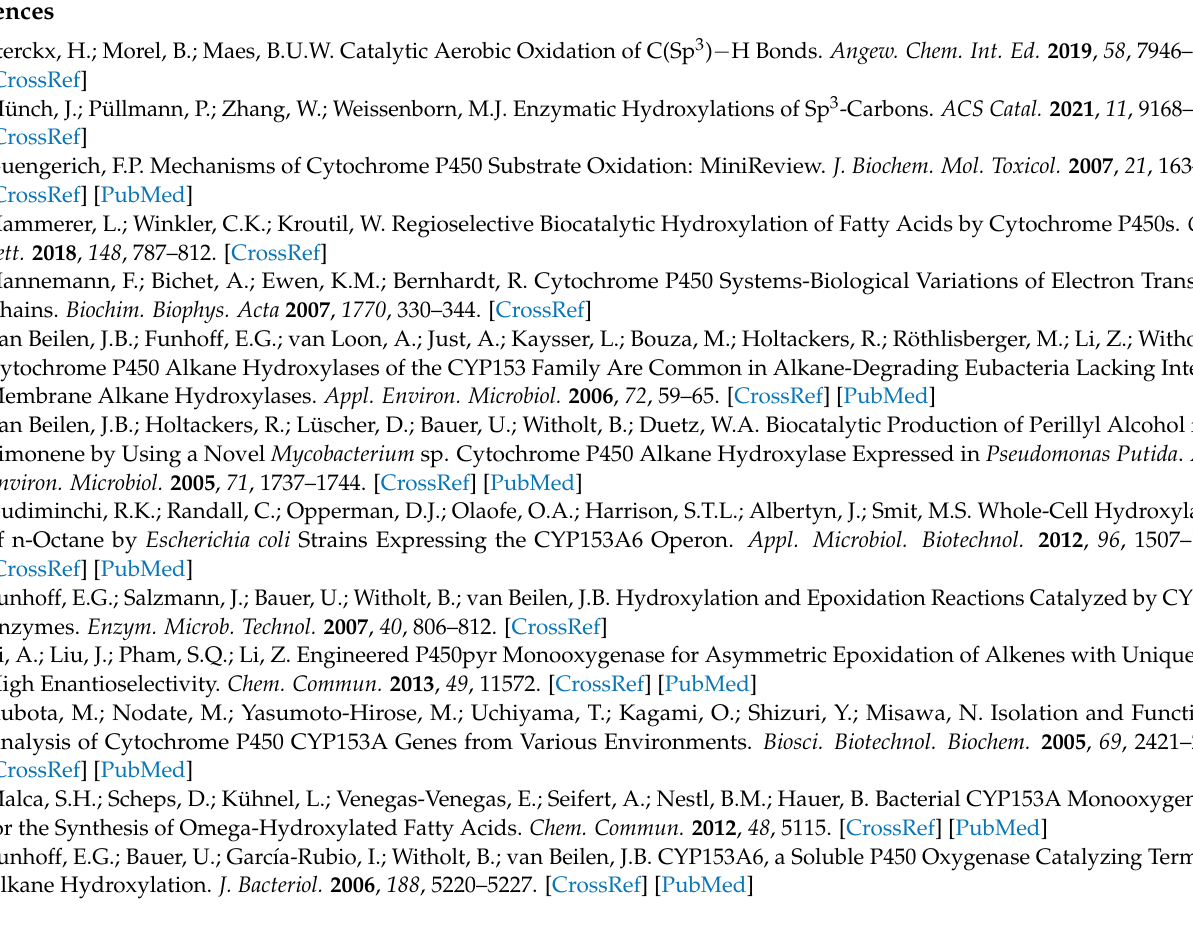
SK2. Table S3: Percentage amino acid sequence identity between different